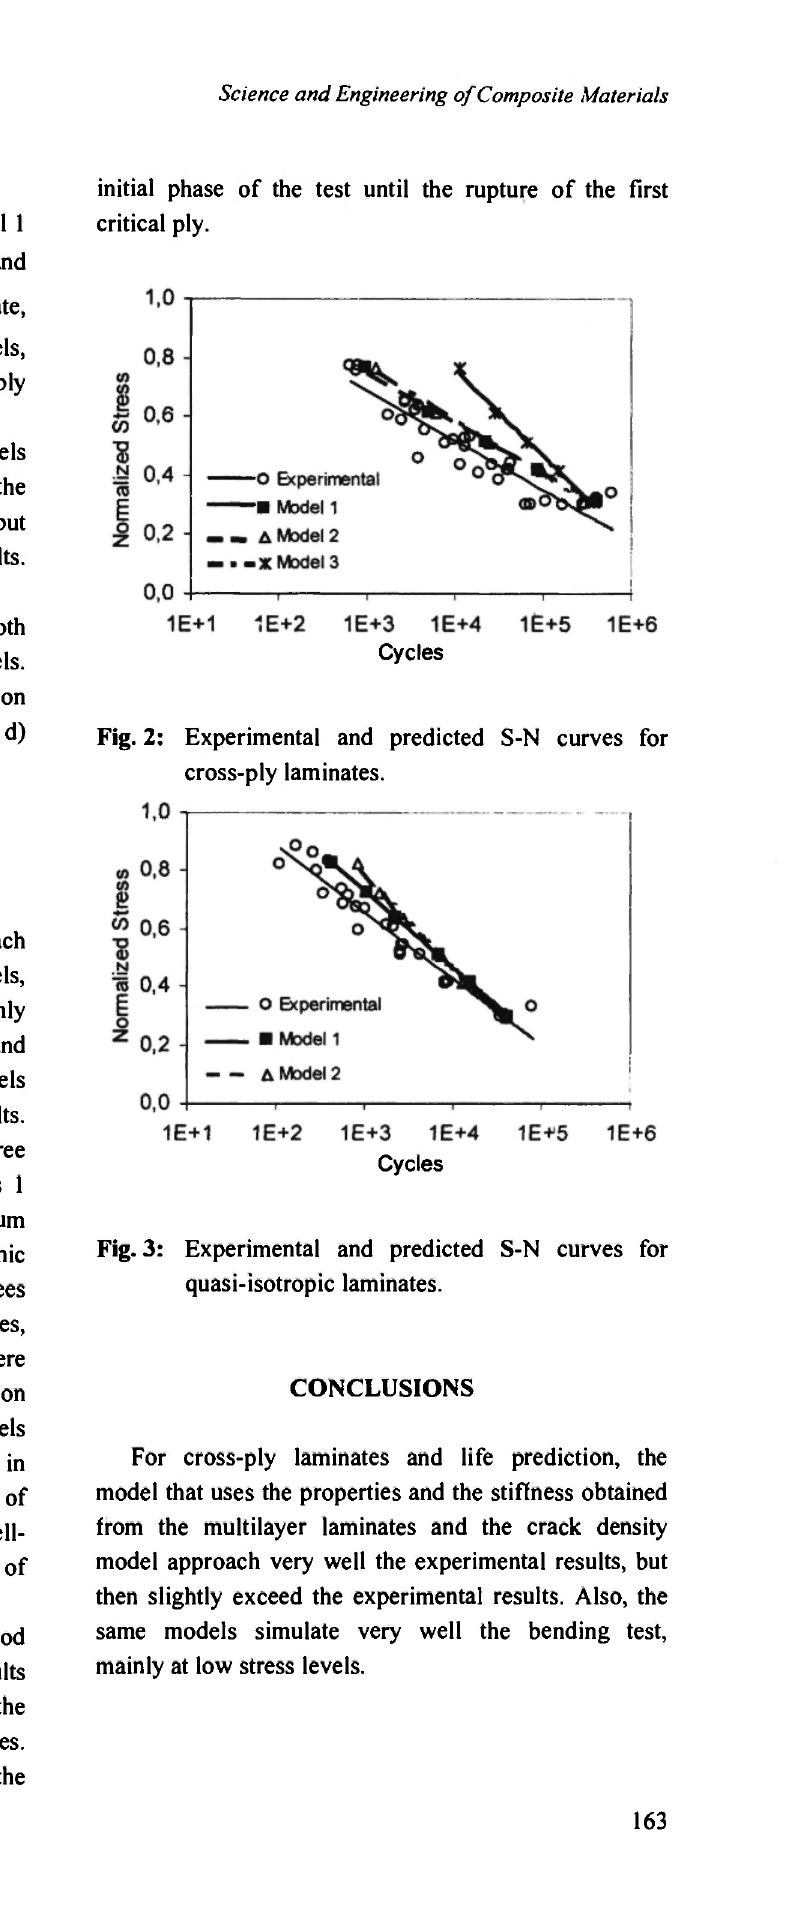
Fig. 3: Experimental and predicted S-N curves for quasi-isotropic